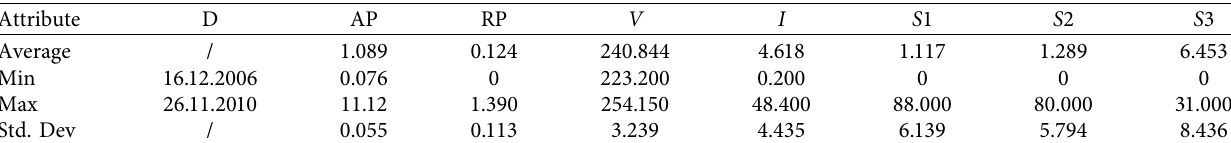
Table 2: Detailed description of the household power dataset [43] with its attributes and quantitative